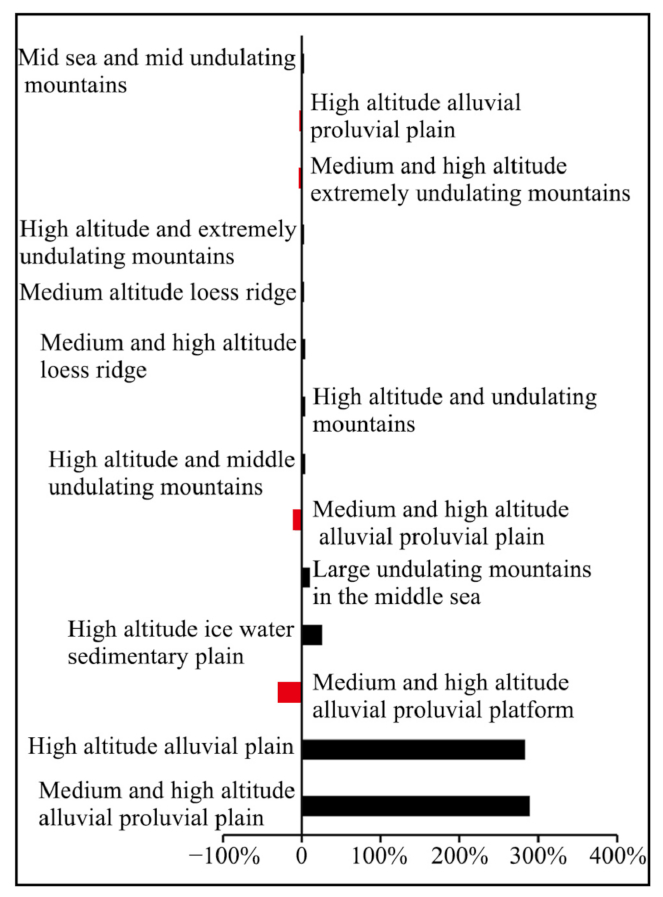
Figure 5. Top 14 geomorphic areas of cultivated land area change from 2000 to